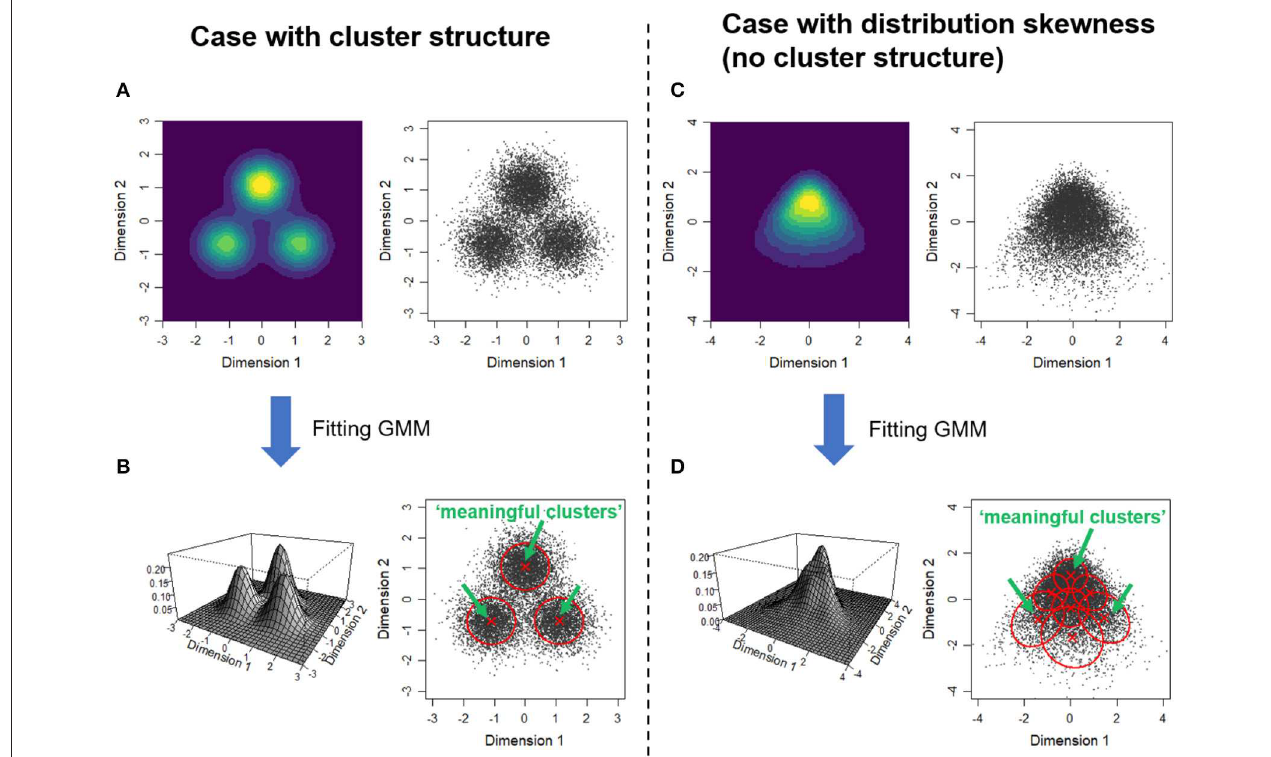
FIGURE 1 | How clustering based on a Gaussian mixture model works for two types of distributions. Comparison of a case with a clear cluster structure (A,B) and a case with a skewed distribution (C,D) . (A,C) The right panel for each shows the scatter plot of synthesized data and the left shows the estimated probability density from the samples. (B,D) Result of fitting Gaussian mixture models. The left panel shows the probability density functions of the fitted GMM. The right panel indicates the one standard deviation contours and the centers of the estimated Gaussian components (the scatter plots that are identical with the above panels are shown). The Gaussian components deemed “meaningful clusters” by Gerlach et al.’s procedure are indicated by green arrows (see Supplementary Text 2 and Supplementary Figure 1 for